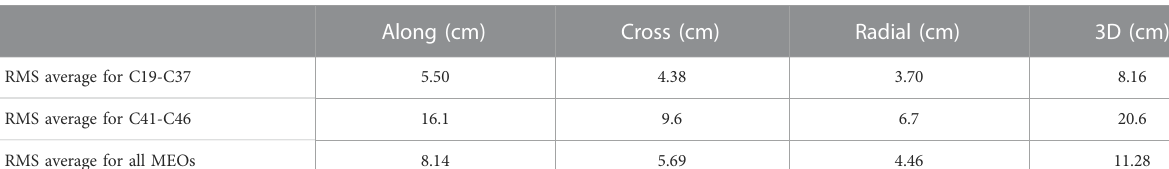
TABLE 5 Statistical RMS values of the BDS-3 MEO satellite orbit.